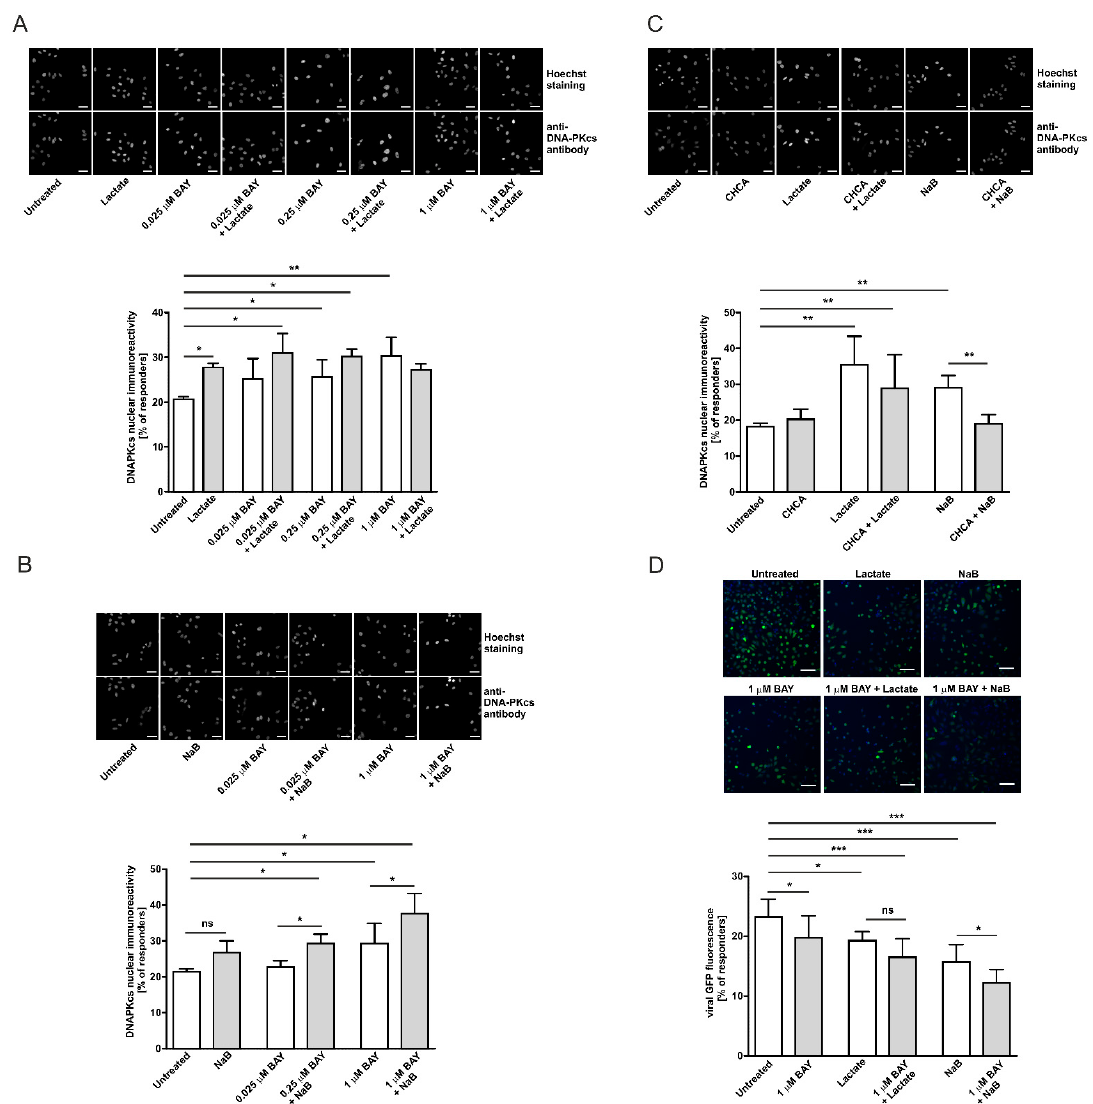
Figure 6. Enhancement of DNA-PKcs nuclear translocation by intra/extracellular lactate is related to monocarboxylate transporter activity.( A ) HeLa cells were treated with increasing concentrations of BAY-8002 (0–1 µ M) for 1h prior to 24 h incubation in the presence or absence of 20 mM L-lactate. The graphs display the percentage of high DNA-PKcs immunoreactive cells (responders) whose fluorescence overcame the threshold of mean fluorescence set on untreated cells. Data are presented as mean ± SD (n ≥ 3) ( B ) HeLa cells were treated with BAY-8002 (0.025 µ M or 1 µ M) for 1h prior to 24 h incubation in the presence or absence of 0.5 mM sodium butyrate. The graphs display the percentage of high DNA-PKcs immunoreactive cells (responders) whose fluorescence overcame the threshold of mean fluorescence set on untreated cells. Data are presented as mean ± SD (n = 3). ( C ) HeLa cells were treated with CHCA at 2 mM concentration for 1 h prior to 24 h incubation in the presence or absence of 20 mM L-lactate or 0.5 mM sodium butyrate. The graphs display the percentage of high DNA-PKcs immunoreactive cells (responders) whose fluorescence overcame the threshold of mean fluorescence set on untreated cells. Data are presented as mean ± SD (n ≥ 3). ( D ) HeLa cells were pretreated either with BAY-8002 1 µ M for 1 h or left untreated prior to 24 h incubation in the presence or absence of 20 mM L-lactate or 0.5 mM sodium butyrate. The next day, cells were infected with GFP Control Lentiviral Particles at MOI = 5 for 24 h before changing the medium. After 48 h, infected cells were stained with Hoechst 33342 and immediately analyzed using an ArrayScan VTI HCS Reader. The graphs show the percentage of high copGFP expressing HeLa cells (responders) whose fluorescence overcame the threshold of mean fluorescence set on untreated cells. Data are presented as mean ± SD (n = 3). Images showed representative microscopic areas for the particular treatment from the same experiment. The scale bar is 50 µ m. * p < 0.05, ** p < 0.01 and *** p < 0.001; not significant,